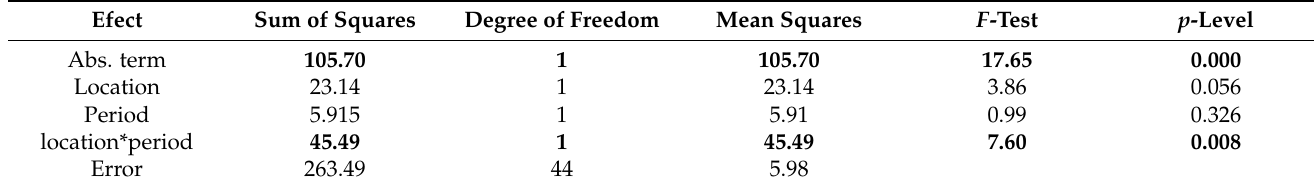
Table 5. One-dimensional test ANOVA for